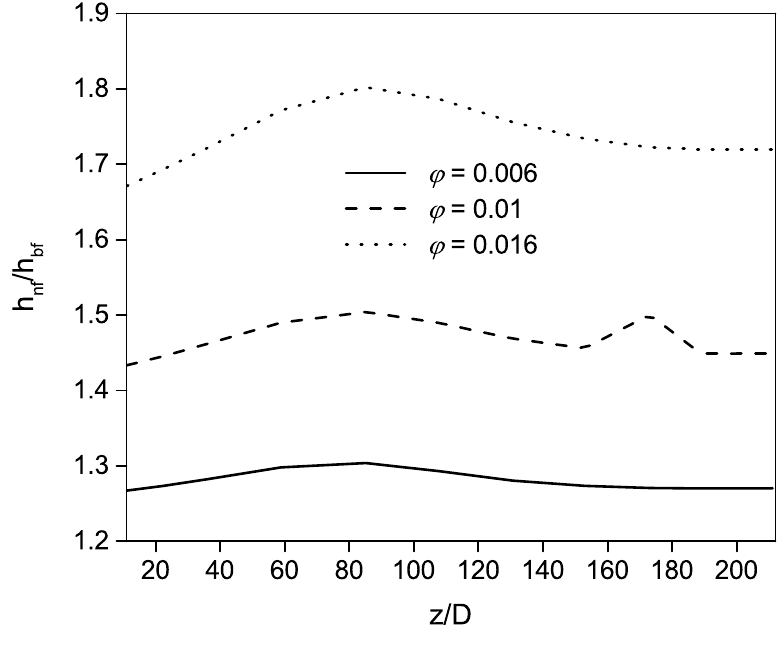
Figure 8. Axial variations of the heat transfer coefficient ratio h nf / h bf for d np = 42 nm, Re = 1600 and three volume fractions in Al 2 O 3 nanoparticles: ϕ = 0.006, 0.01 and